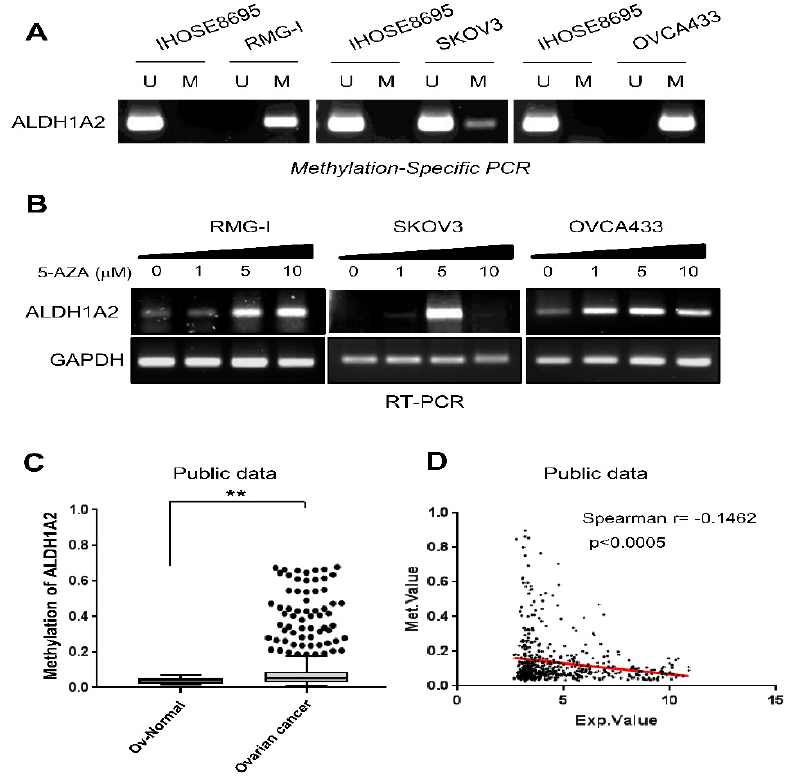
Figure 2. Methylation status of the ALDH1A2 gene in ovarian cancer. ( A ) Analysis of ALDH1A2 methylation in RMG1, SKOV3, and OVCA433 cells by methylation-specific PCR. U, primer pair specific to unmethylated DNA; M, primer pair specific to methylated DNA. ( B ) qRT-PCR analysis of ALDH1A2 mRNA levels in 5-Aza-CdR-treated and control cells. GAPDH was used as loading control. ( C ) Methylation status of ALDH1A2 in the Methylation and Expression database of Normal and Tumor tissues (MENT; http: // mgrc.kribb.re.kr:8080 / MENT / ). A Mann–Whitney test was used to evaluate statistical significances. ** p < 0.05. ( D ) Correlation between DNA methylation and gene